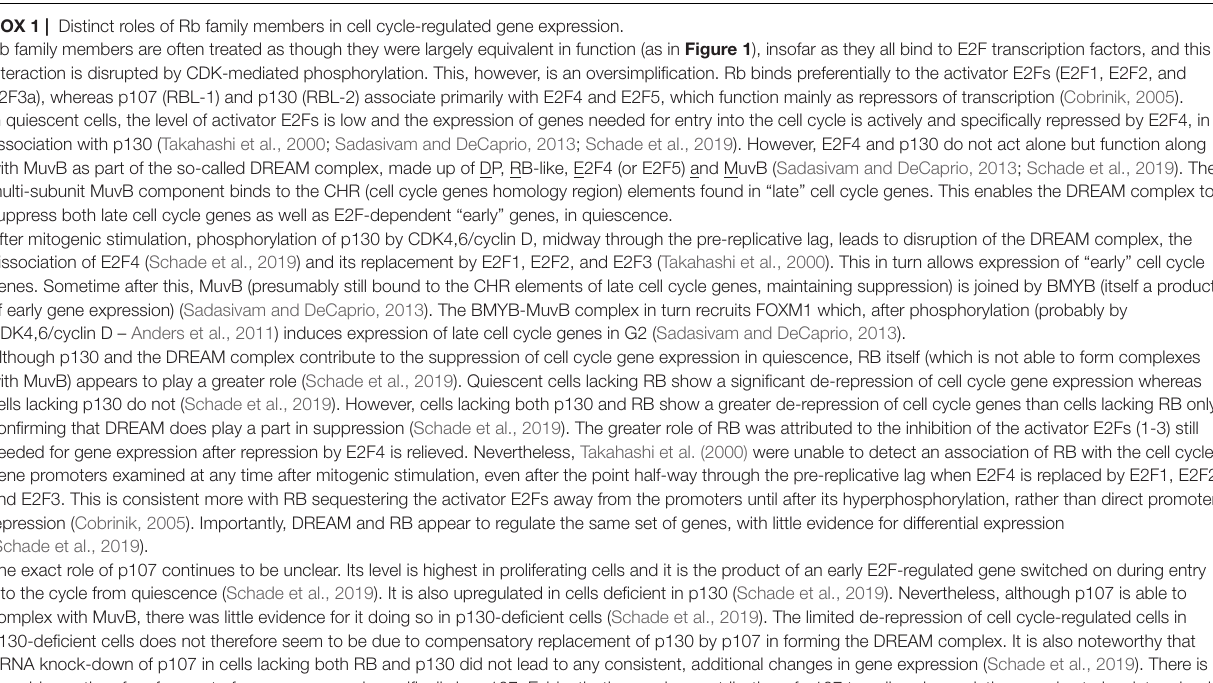
(size variation, for example, or local differences in cell density) (Yao et al., 2008). Later, a stochastic version of the model was indeed able to generate asynchronous switching within a